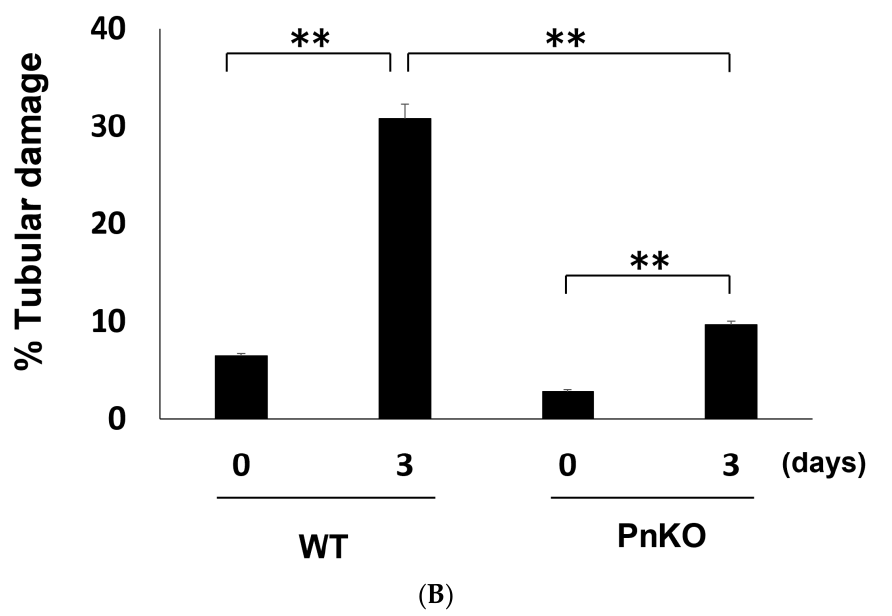
Figure 4. ( A ) The tubular damage in Hematoxylin-Eosin (H-E) staining (×100). Tubular damage in wildtype and Pn-null rhabdomyolysis mouse model kidney. Periostin-null mice exhibited reduced tubular damage in the kidney. ( B ) The evaluation of the degree of tubular damage in wildtype and Pn-null rhabdomyolysis mouse model kidney. The tubular damage was defined by tubular epithelial necrosis, intratubular debris, and loss of brush border. The tubular damage score was 0: normal, 1: 1–25% damaged, 2: 26–50% damaged, 3: 51–75% damaged, and 4: 76–100% damaged. We examined 40 fields at random. Injury score (%) = (numbers of injured tubules/number of whole tubules) × 100. ** p < 0.01 vs. day 0 (WT) and day 3 (PnKO) n = 6. The expression of periostin and inflammation markers in the kidney are shown in Figure 5. All markers of inflammation were elevated in the wildtype mice on day 3 after 50% glycerol injection. On the other hand, all markers of inflammation declined significantly in the Pn-null mice on day 3 after 50% glycerol injection compared with WT. In addition, the expression of periostin in the kidney were significantly associated with % Tubular damage score (H-E staining) in the univariate linear regression analysis model (Supplement Table S1).